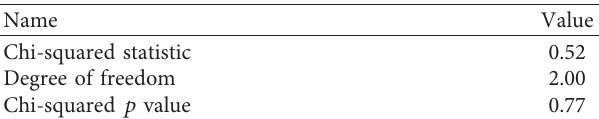
Table 3: Goodness of fit of negative binomial to the distribution of the number of exceedances.